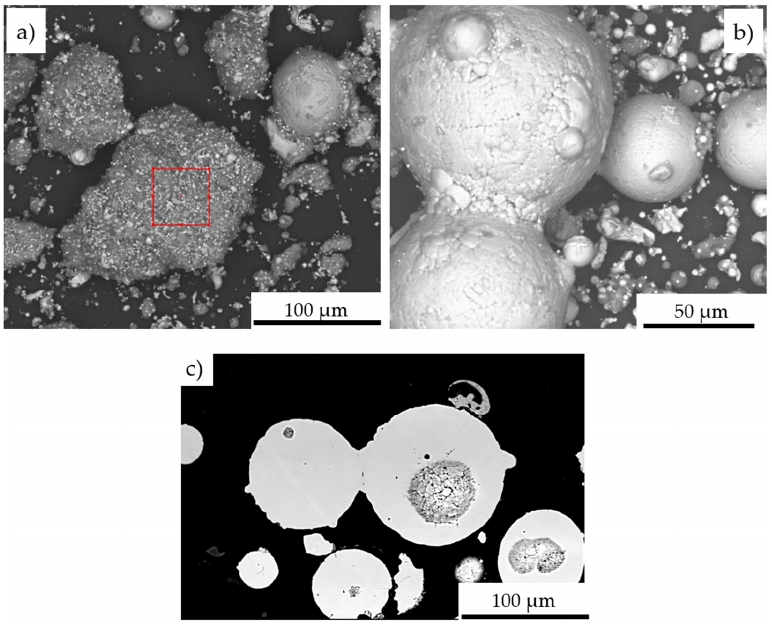
Figure 14. Morphology of Fe40Al at.% powder particles after DGS spraying into water: agglomerate formed from melted particles with the EDS analysis area marked ( a ); welding of two larger FeAl powder particles with larger dimensions ( b ); the cross-section of the FeAl particles welded together with the pores in the particle volume ( c ). Table 7. Average results of SEM/EDS chemical composition tests on the surface of agglomerates formed from melted FeAl powder particles under specific DGS spraying conditions. Content of the Elements wt.% at.% Fe 21.7 9.3 ± 7.2